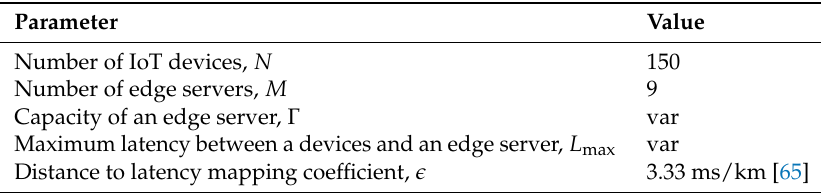
Table 2. Main simulation parameters.